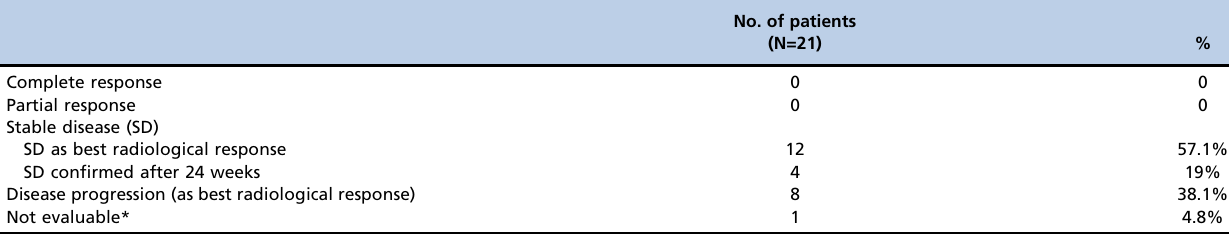
Table 2 - Radiological response in the intention-to-treat population with advanced hormone-receptor positive breast cancer treated with anti-Lewis Y monoclonal antibody (hu3S193).